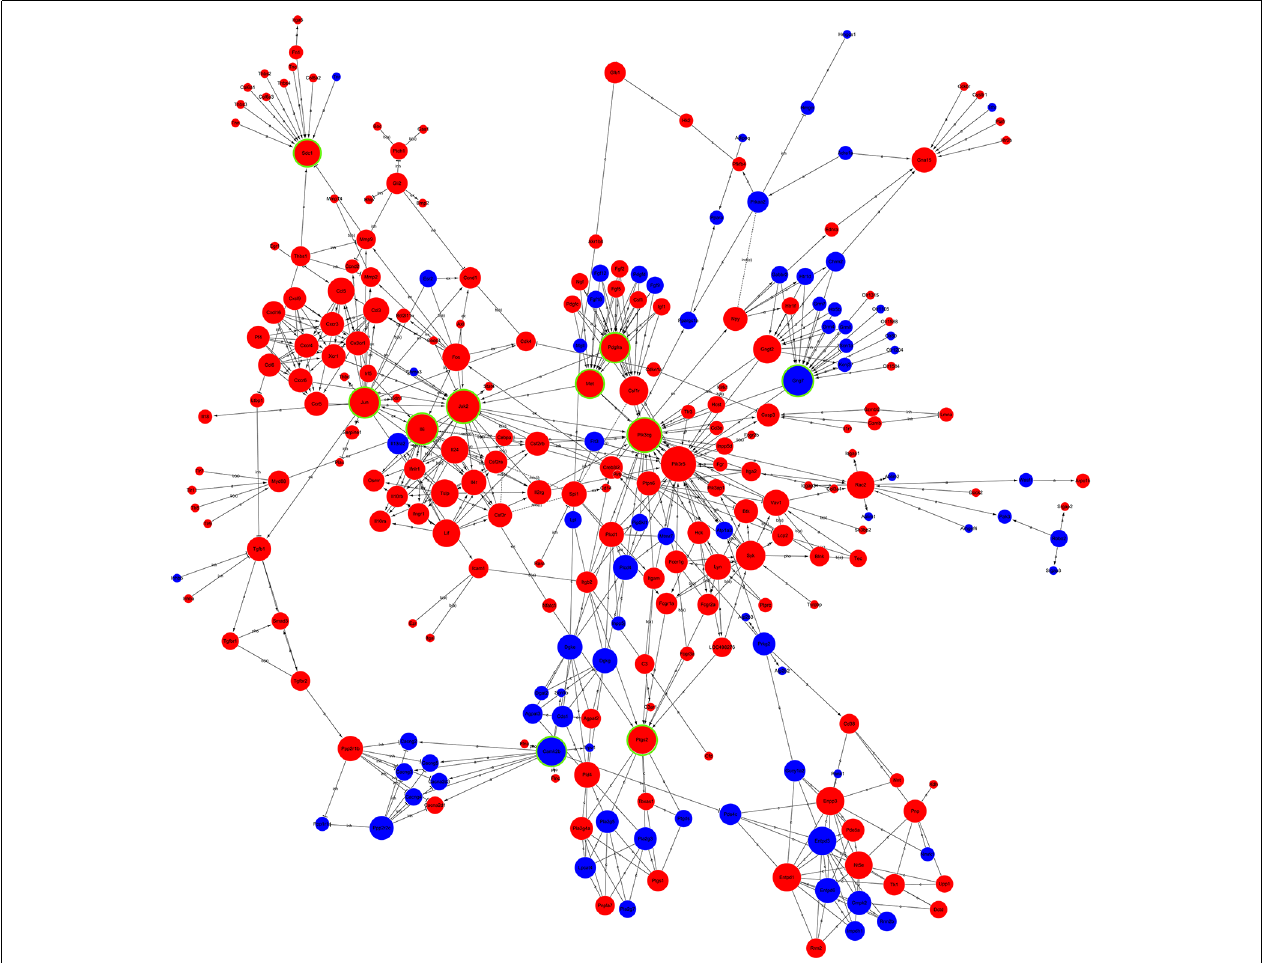
FIGURE 5 | Global signal transduction network of DEGs. The red node represents an upregulated gene, and the blue node represents the downregulated gene. The lines exhibit the interaction between the genes. The size of the node indicates the degree of interacting with other genes. The more important the genes are, the larger the node is. Nodes with green rings were the genes that were selected to be experimentally validated.